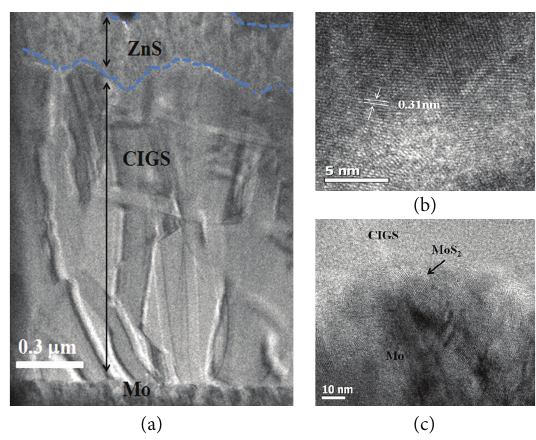
Figure 3: (a) TEM cross-section images of ZnS/CIGS/Mo, (b) high- resolution TEM image of the cubic ZnS film, and (c) the interface of CIGS and Mo.